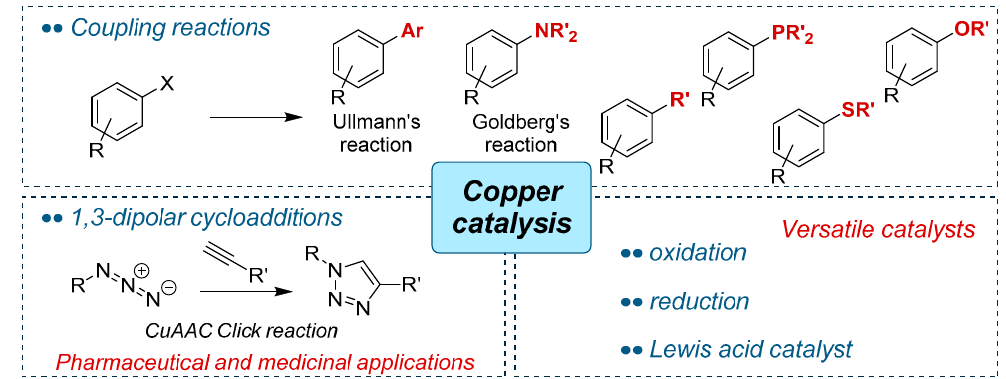
Figure 1. A representation of different reactivities of copper species .